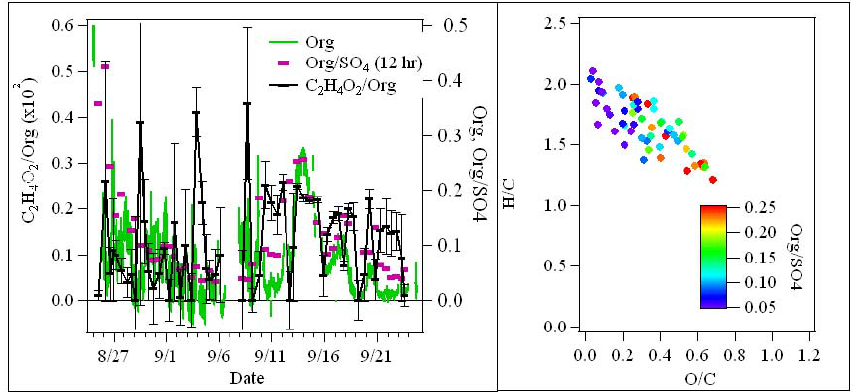
Fig. 10. (Left) Time series of Org (10 min average), Org/SO 4 (12h average), and C 2 H 4 O 2 (12h). One sigma errors for the data are indicated. (Right) H/C vs. O/C for the 12h averaged data (Van Krevelen